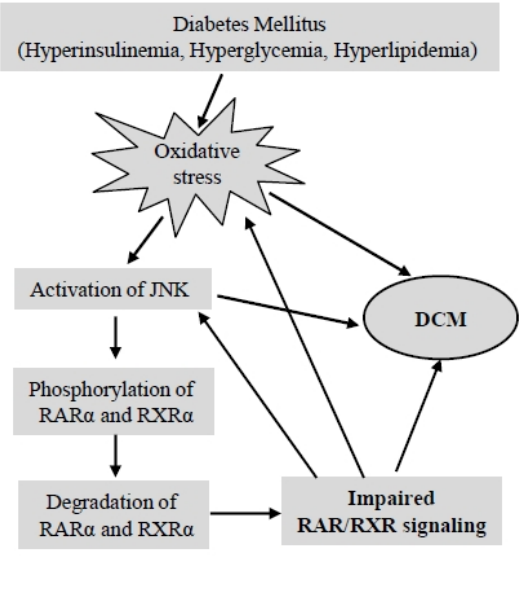
Figure 4. Schematic of the interaction between diabetes mellitus (DM), JNK and impaired RAR/RXR signaling in DCM. Mechanisms of DM-induced oxidative stress and JNK activation in the regulation of phosphorylation/transcriptional inhibition of RAR α and RXR α and the development of DCM are